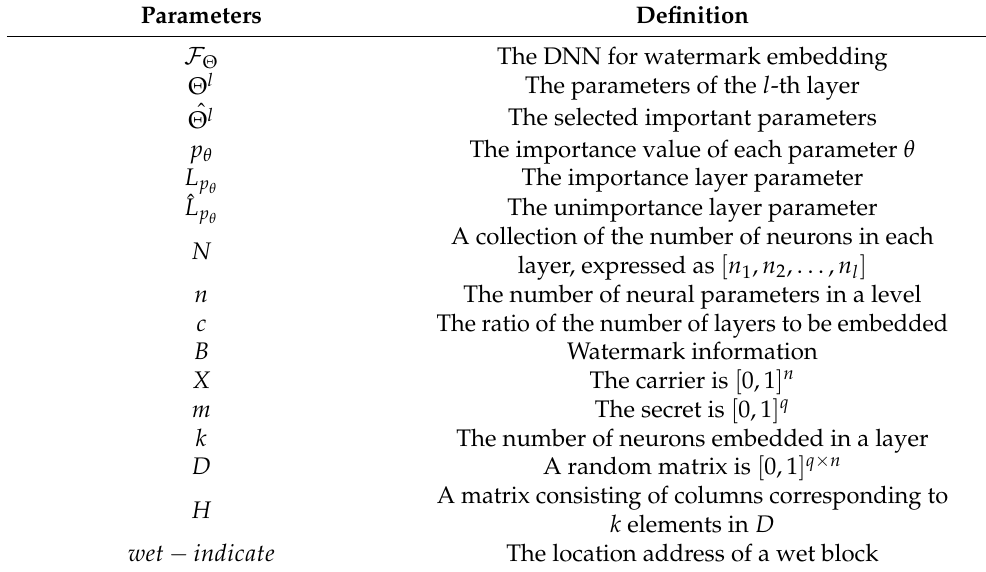
Table 1. The information embedding ratio is the ratio of all parameters of the model to the amount of information embedded in the